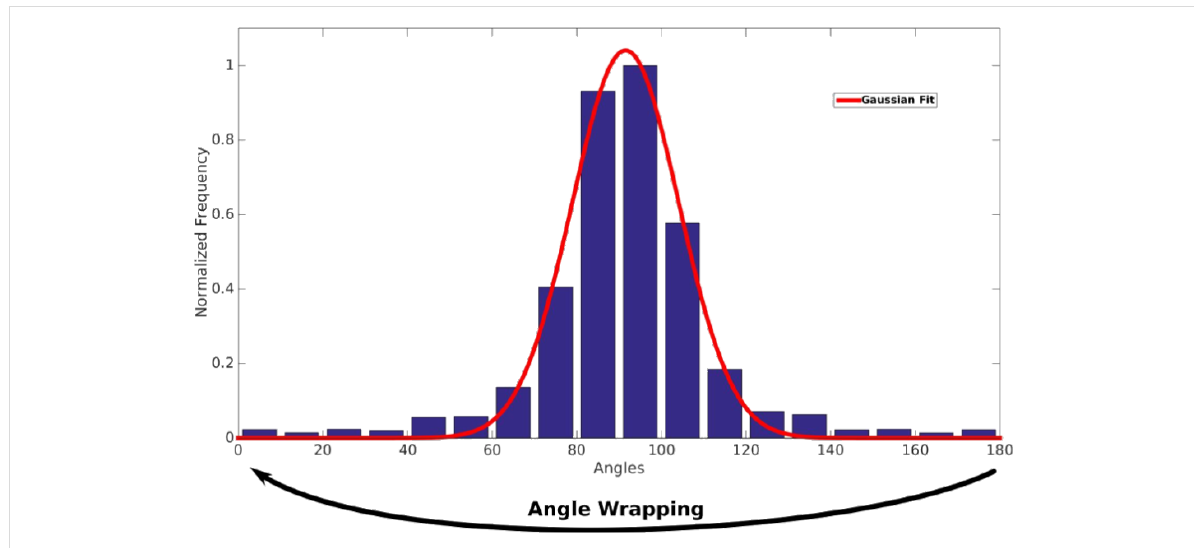
Figure 6: Calculation of HOG descriptor. The histogram corresponding to the pixels of one cell. A 17-bin histogram of 0–170° is used. Gradients of every pixel are accumulated in the columns; the angles wrap around, i.e., 180° is equivalent to 0°. The histogram is fitted using a normal Gaussian distribution, and the Gaussian FWHM is computed.